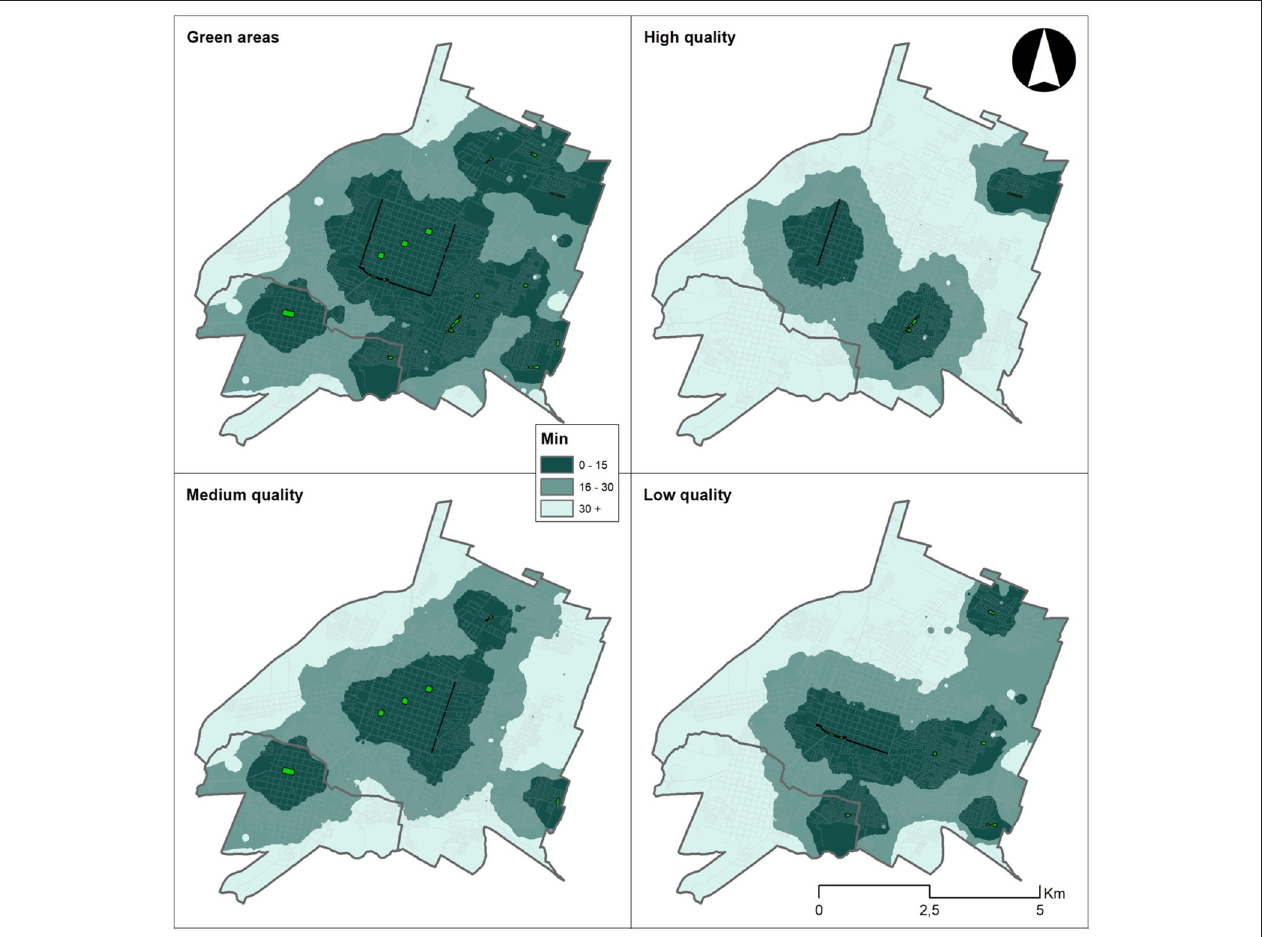
FIGURE 10 | Accessibility of green areas in Chillán, with green space quality levels obtained from the survey.